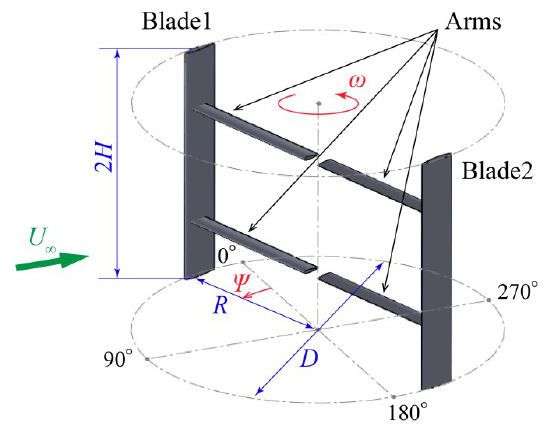
Figure 1. Small straight-bladed vertical axis wind turbine targeted for the computational fluid dynamics (CFD) analysis. Table 1. Rotor size parameters.